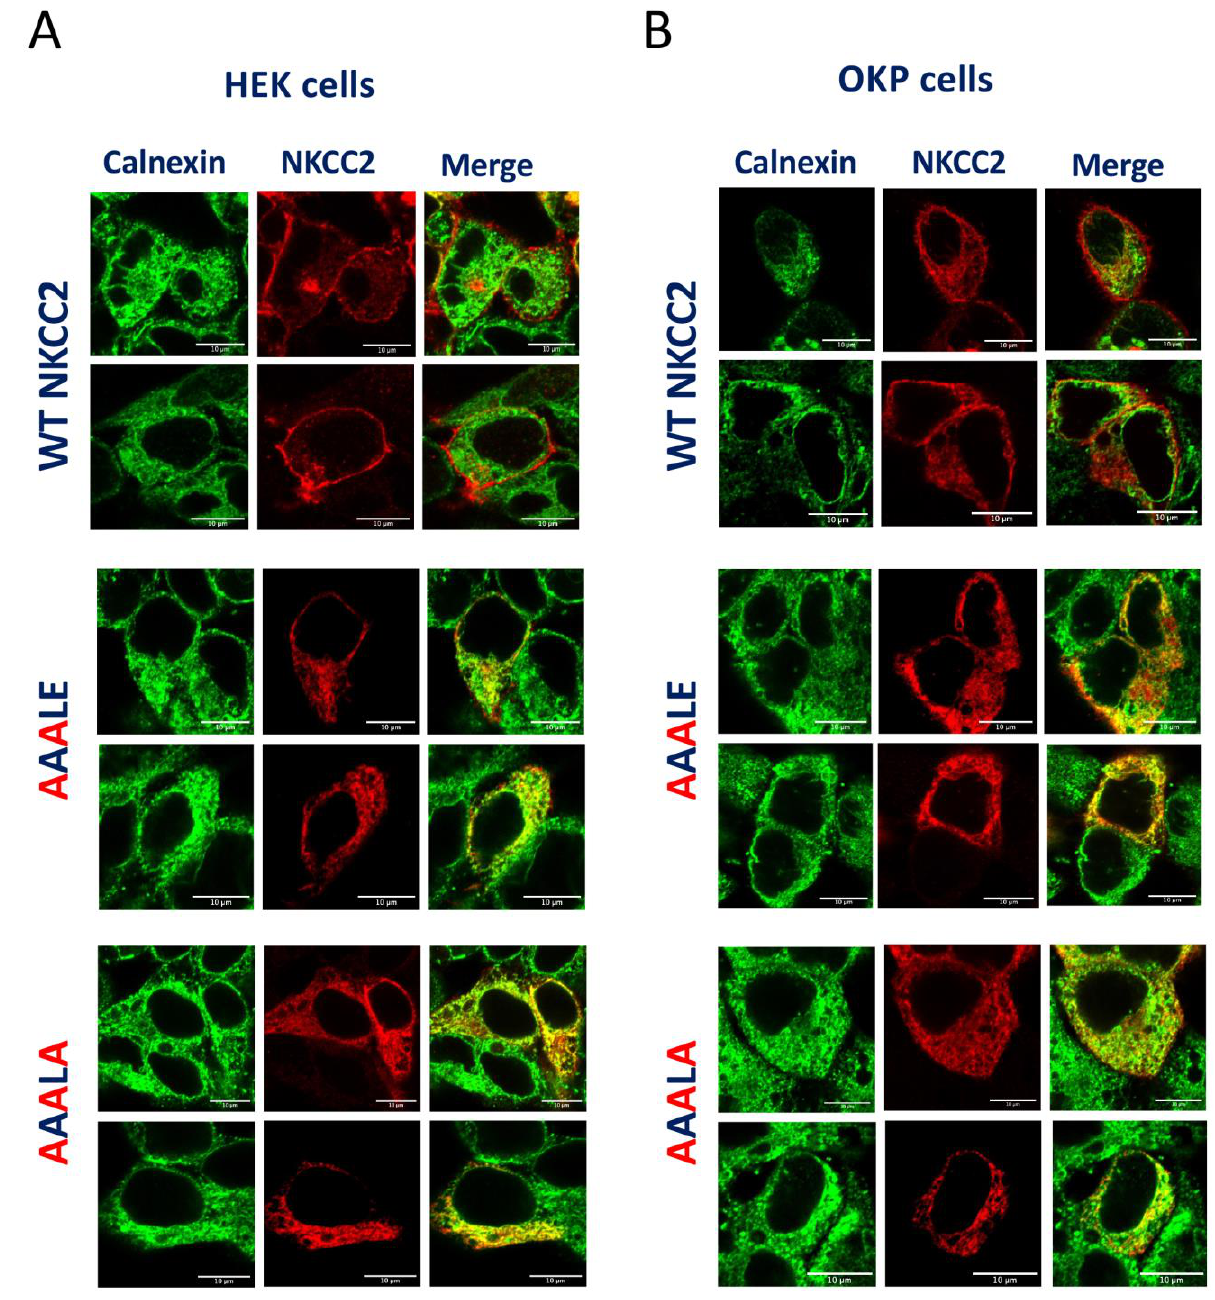
Figure 4. 1019 AAALE 1023 and 1019 AAALA 1023 are not expressed at the cell surface due to retention in the endoplasmic reticulum. Transiently transfected HEK cells ( A ) or OKP cells ( B ) with wild-type or 1019 AAALE 1023 and 1019 AAALA 1023 , as indicated, were fixed and permeabilized, and then cells were stained with mouse anti-Myc (Texas red; red)) and rabbit anti-calnexin (fluorescein isothiocyanate; green). Yellow, overlap between the Myc tag of NKCC2 protein (red) and the ER marker (green), representing co-localization of the proteins at the ER. Bars, 10 µm. 2.5. Mutation of the 1019 DAELE 1023 Motif Impaired Maturation of the Cotransporter